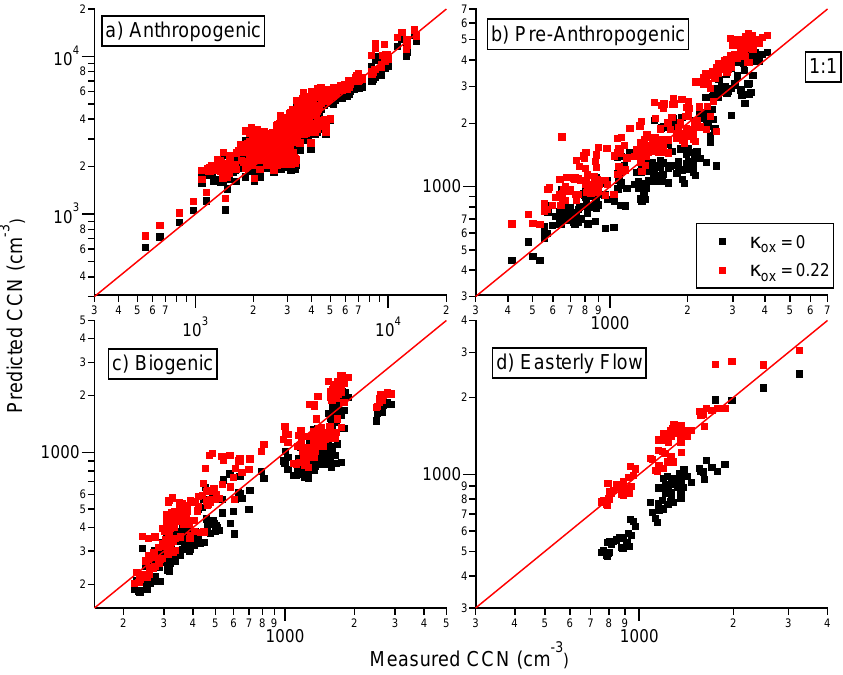
Fig. 6. Comparison of predicted and measured CCN concentrations for different time periods (see Fig. 3) with κ ox =0 (black) and 0.22 (red). The lines are 1:1